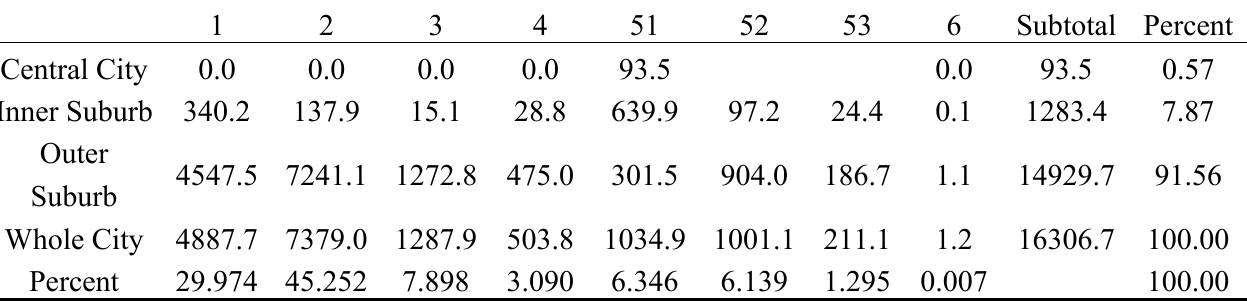
Table 2. Land use by categories and by suburban rings in 2000 (hundred